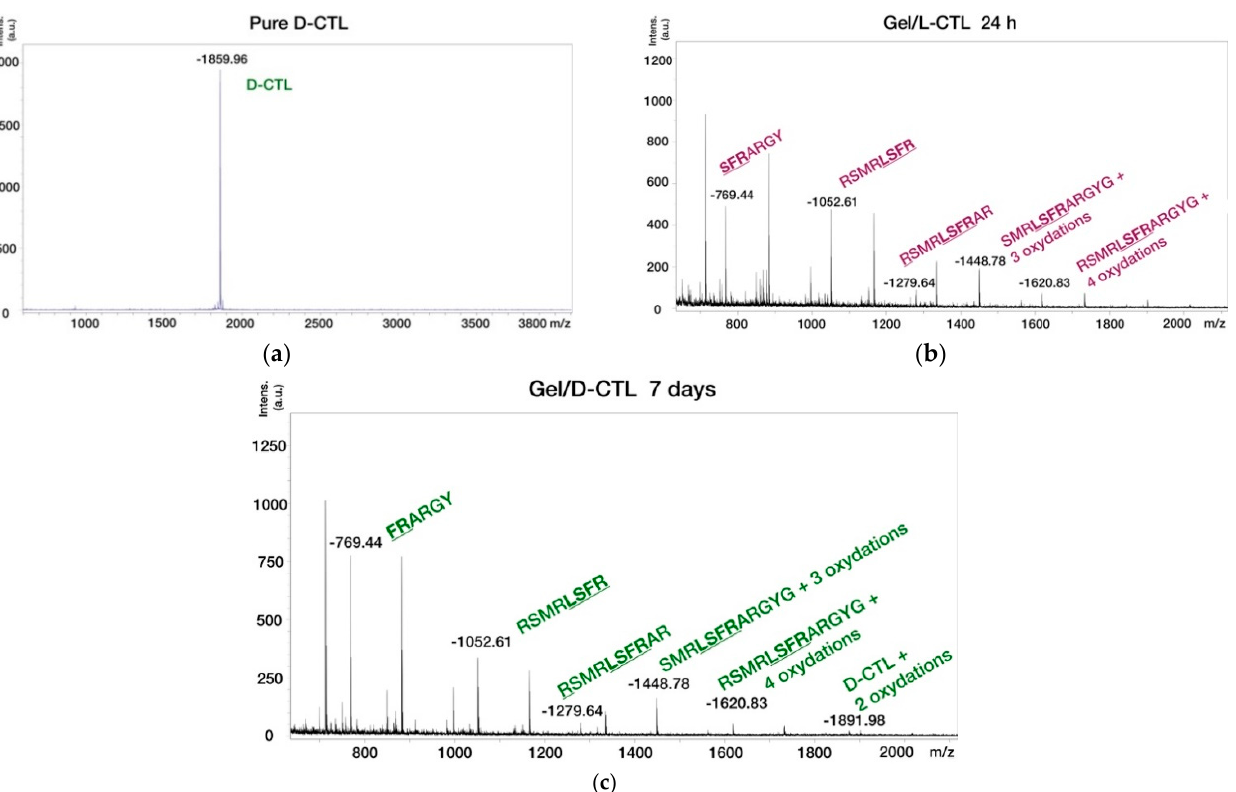
Figure A1. HPLC analysis of CTL (at + 24 h). Black curves ( 1 ) show a main peak corresponding to the reduced and active form of L-CTL ( a ) and D-CTL ( b ). Profiles of curves are similar between L and D-CTL. Blue curves ( 2 ) display a main peak (salts), followed by several secondaries (seven) peaks that correspond to peptides in the supernatant of the gel after 24 h (and it is similar after 7 days). The complete characterization of the fragments indicated by blue arrows ( ↓ ) is obtained with MALDI–TOF analysis (Appendix A Figure A2).